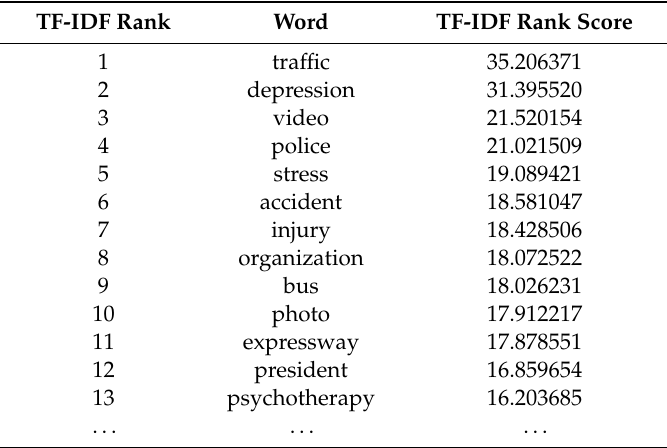
Table 6. Results of the TF-IDF Rank Score.